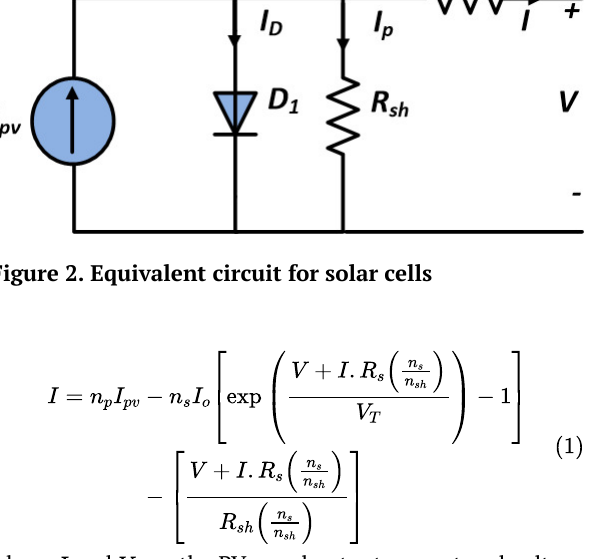
off-grid hybrid power system consisting of PV/Wind/fuel